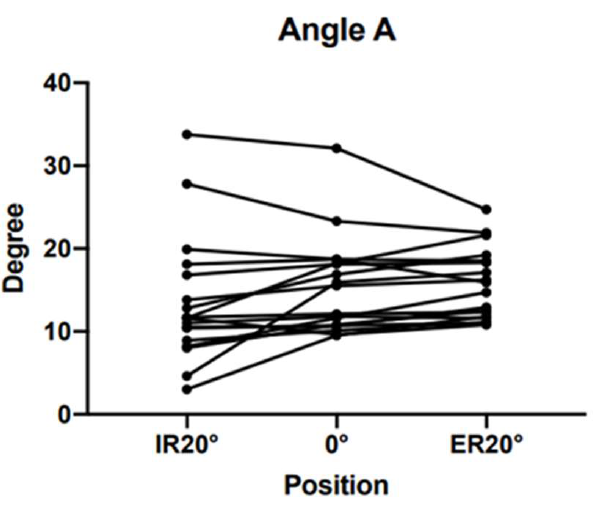
Figure 4. Distribution of Angle A in the three shoulder positions. ER, external rotation; IR, internal rotation.